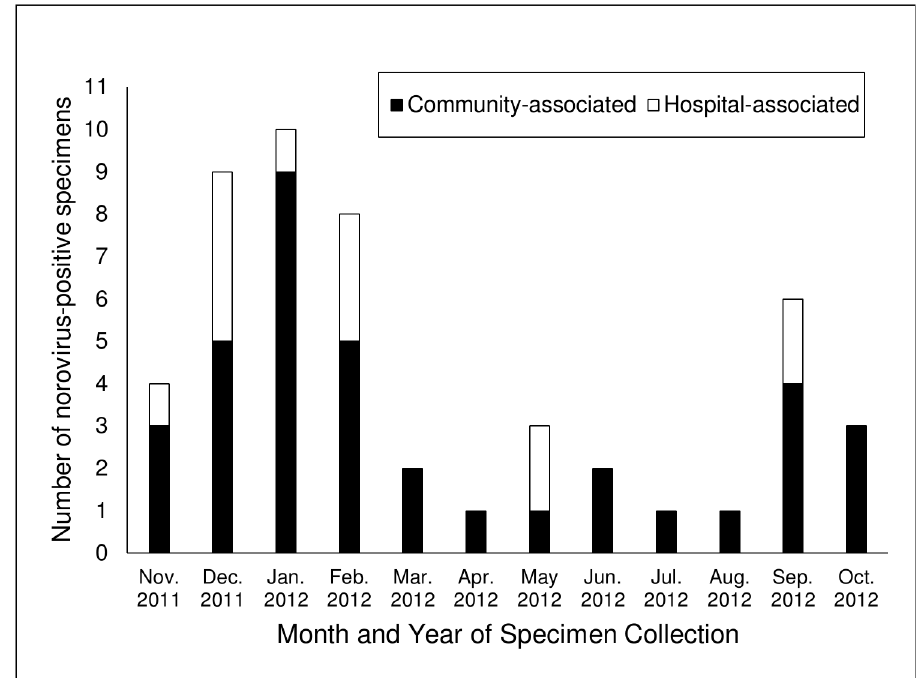
Fig 1. Number of norovirus-positive specimens, by source of infection; 4 VAMCs, November 2011-October 2012.